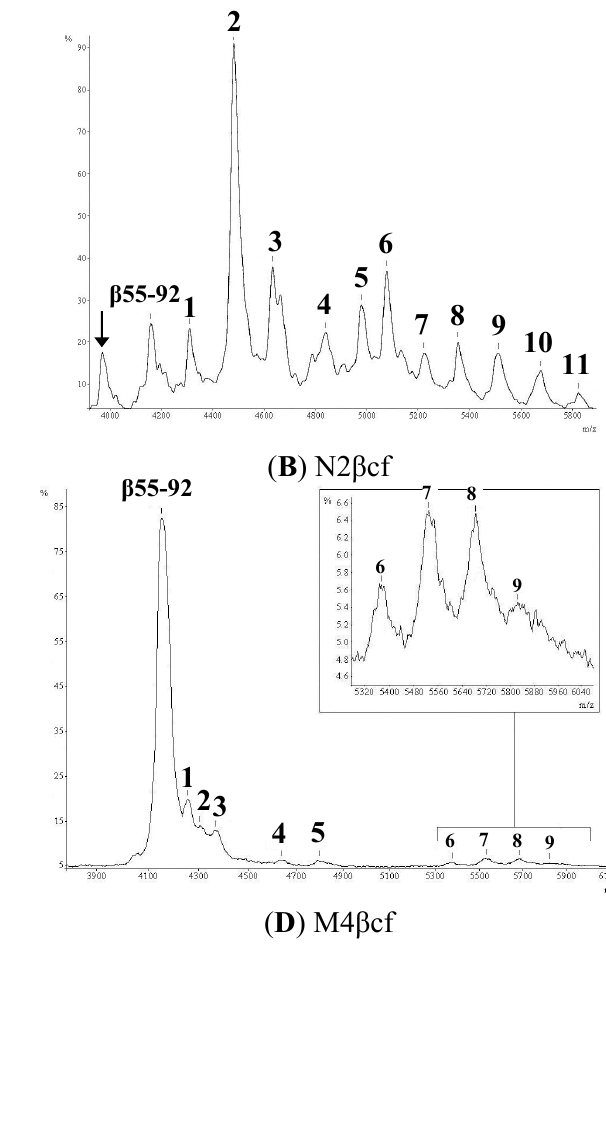
Figure 1. Matrix-assisted laser desorption/ionization time-of-flight mass spectrometry (MALDI TOF MS) of human chorionic gonadotropin β -core fragment (hCG β cf) treated with dithiothreitol (DTT). hCG β cf purified from pregnancy urine samples; Normal ( A , B ), Molar ( C , D ) and Hyperemesis Gravidarium ( E ). Disulfide linkages were reduced using DTT. The indicated peak at m / z 4156.8 ( β 55–92) appears in all samples and represents the unglycosylated peptide of beta-core. Arrowed peak ( ↓ ) only appears in samples N2 β cf and HG β cf and indicates a fragment smaller than β 55–92 and as such is likely to be β 6–40 with minimal or no-glycosylation. All remaining peaks are attributed β 6–40 glycopeptides and described in Table